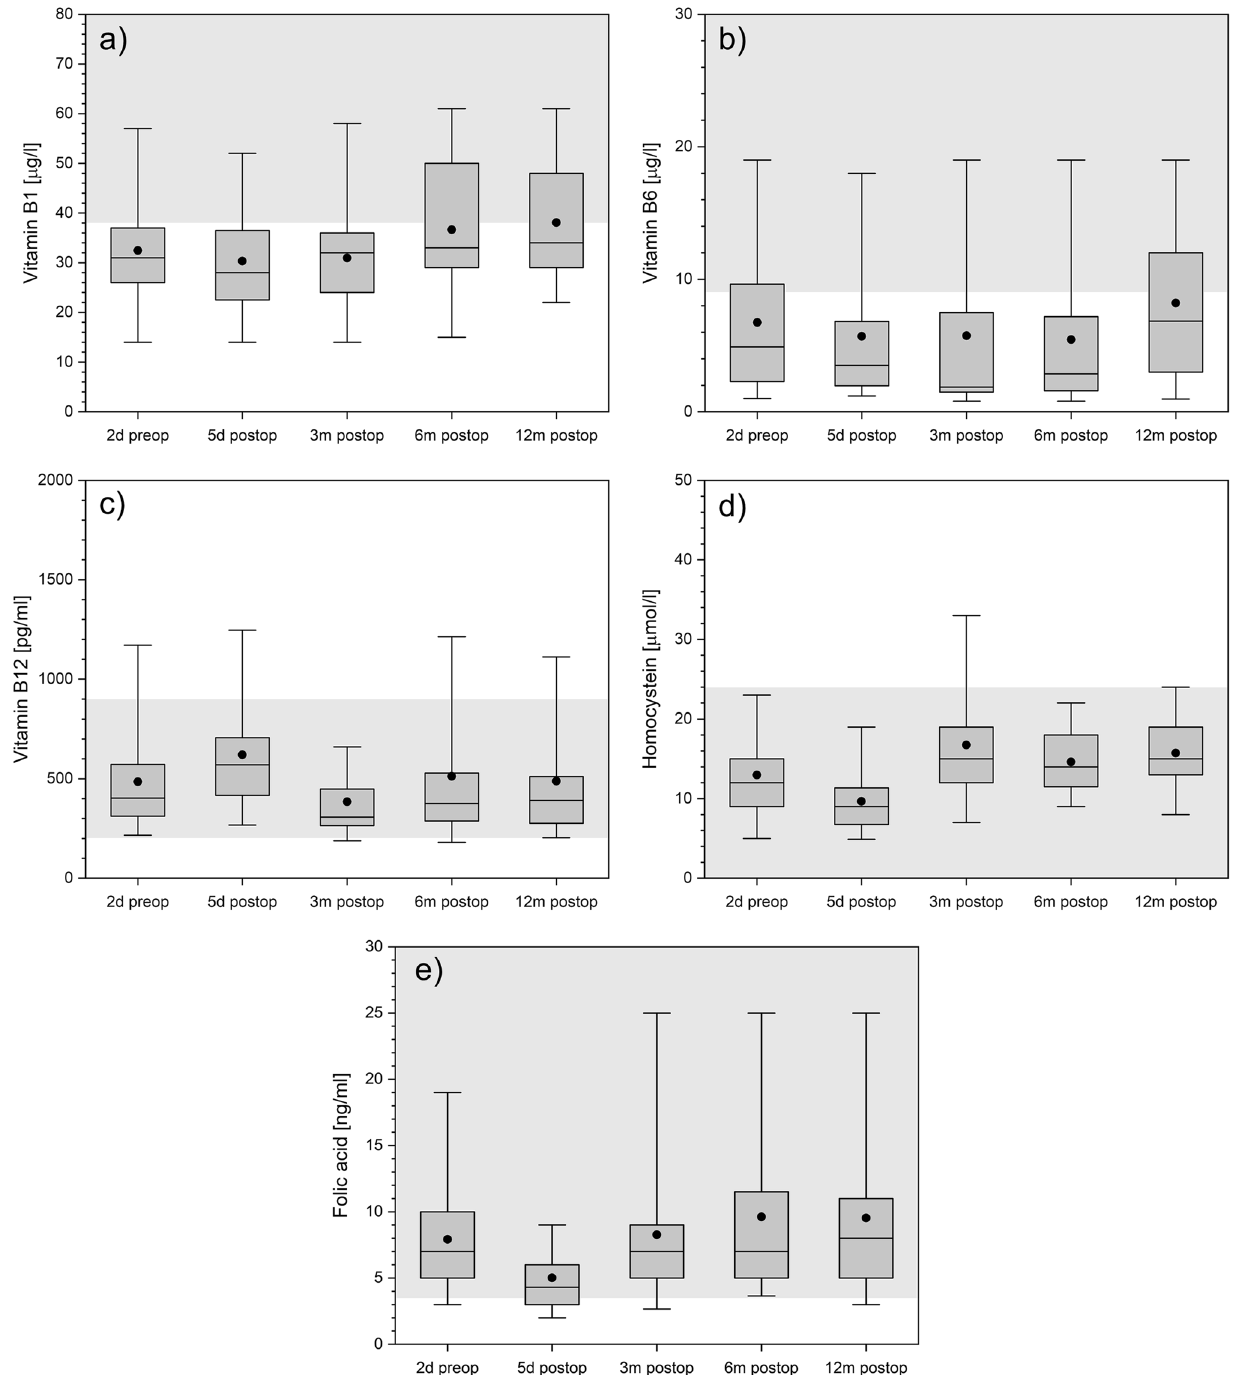
Figure 9. Vitamins B1 (panel a ), B6 (panel b ), and B12 (panel c ), as well as homocysteine (panel d ) and folic acid (panel e ) over time. The boxes contain the 25% and the 75% quartile as well as the median, black dots depict the mean, and whiskers range from the 5% percentile to the 95% percentile. Gray areas depict the normal range for each